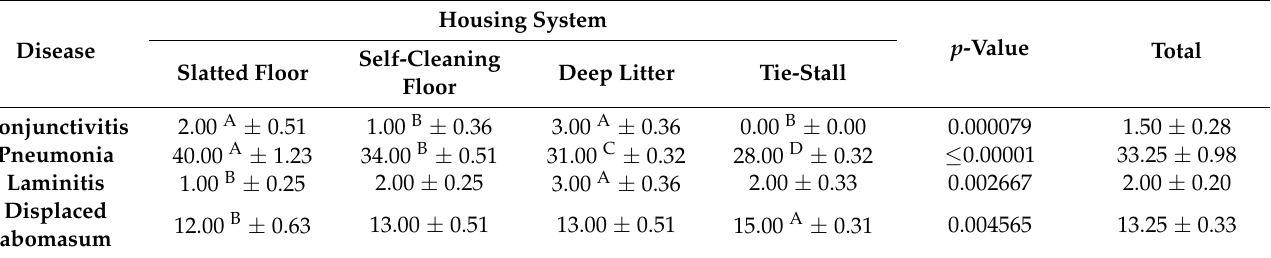
Table 6. Other diseases affecting dairy cows kept in different housing systems in 2015–2020 (mean ± SEM).